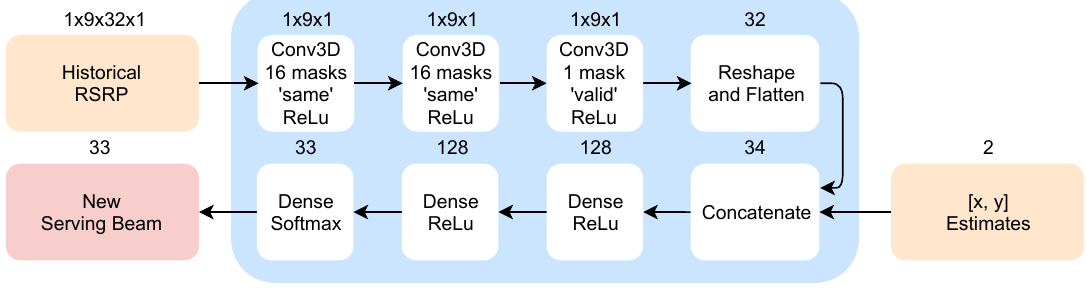
Figure 4. Proposed beam-level mobility model architecture.